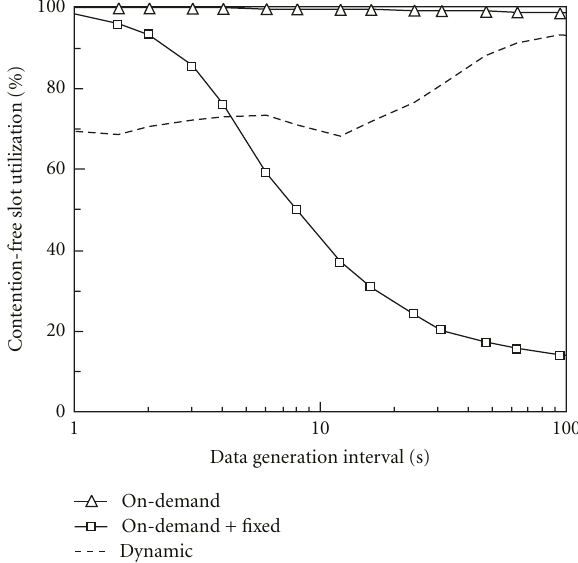
Figure 19: Utilization of granted contention-free slots with di ff er- ent contention-free slot allocation